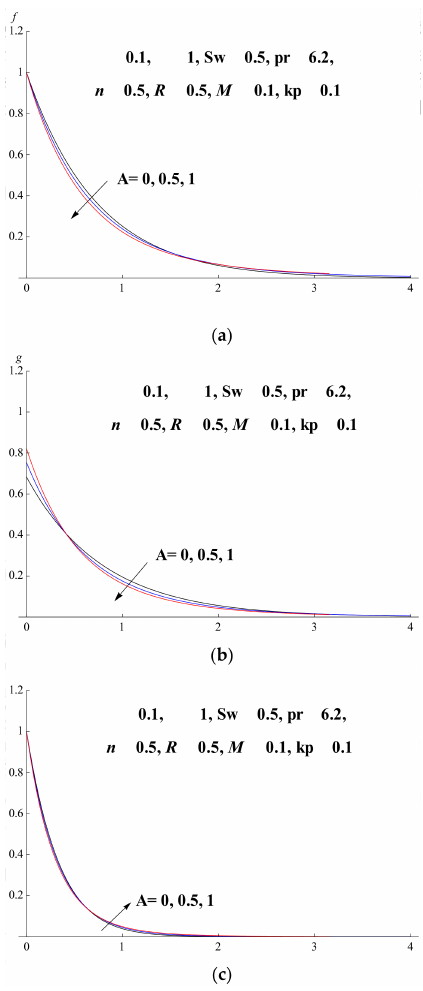
Figure 3. Influence of the unsteadiness parameter ( A ). ( a ) Velocity profile, ( b ) angular velocity profile, and ( c ) temperature